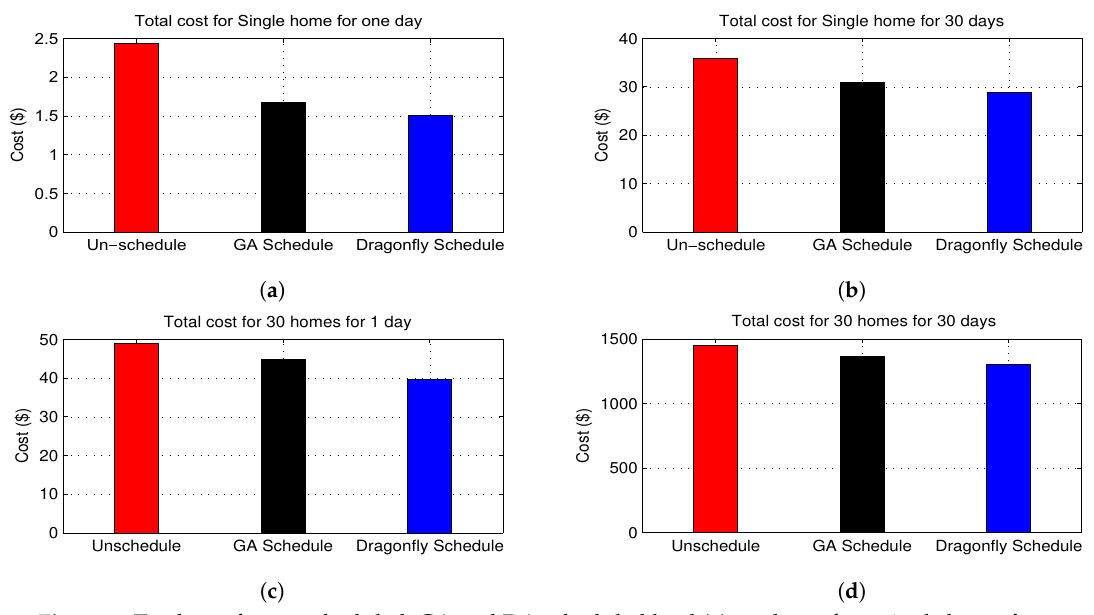
Figure 7. Total cost for un-scheduled, GA and DA scheduled load ( a ) total cost for a single home for one day; ( b ) total cost for a single home for 30 days; ( c ) total cost for 30 homes for one day; ( d ) total cost for 30 homes for 30